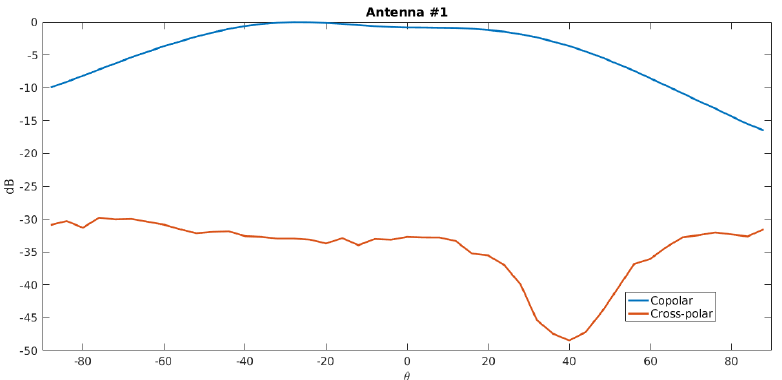
Figure 4. Measured cross polarization when all the patches are in the “ON” state.